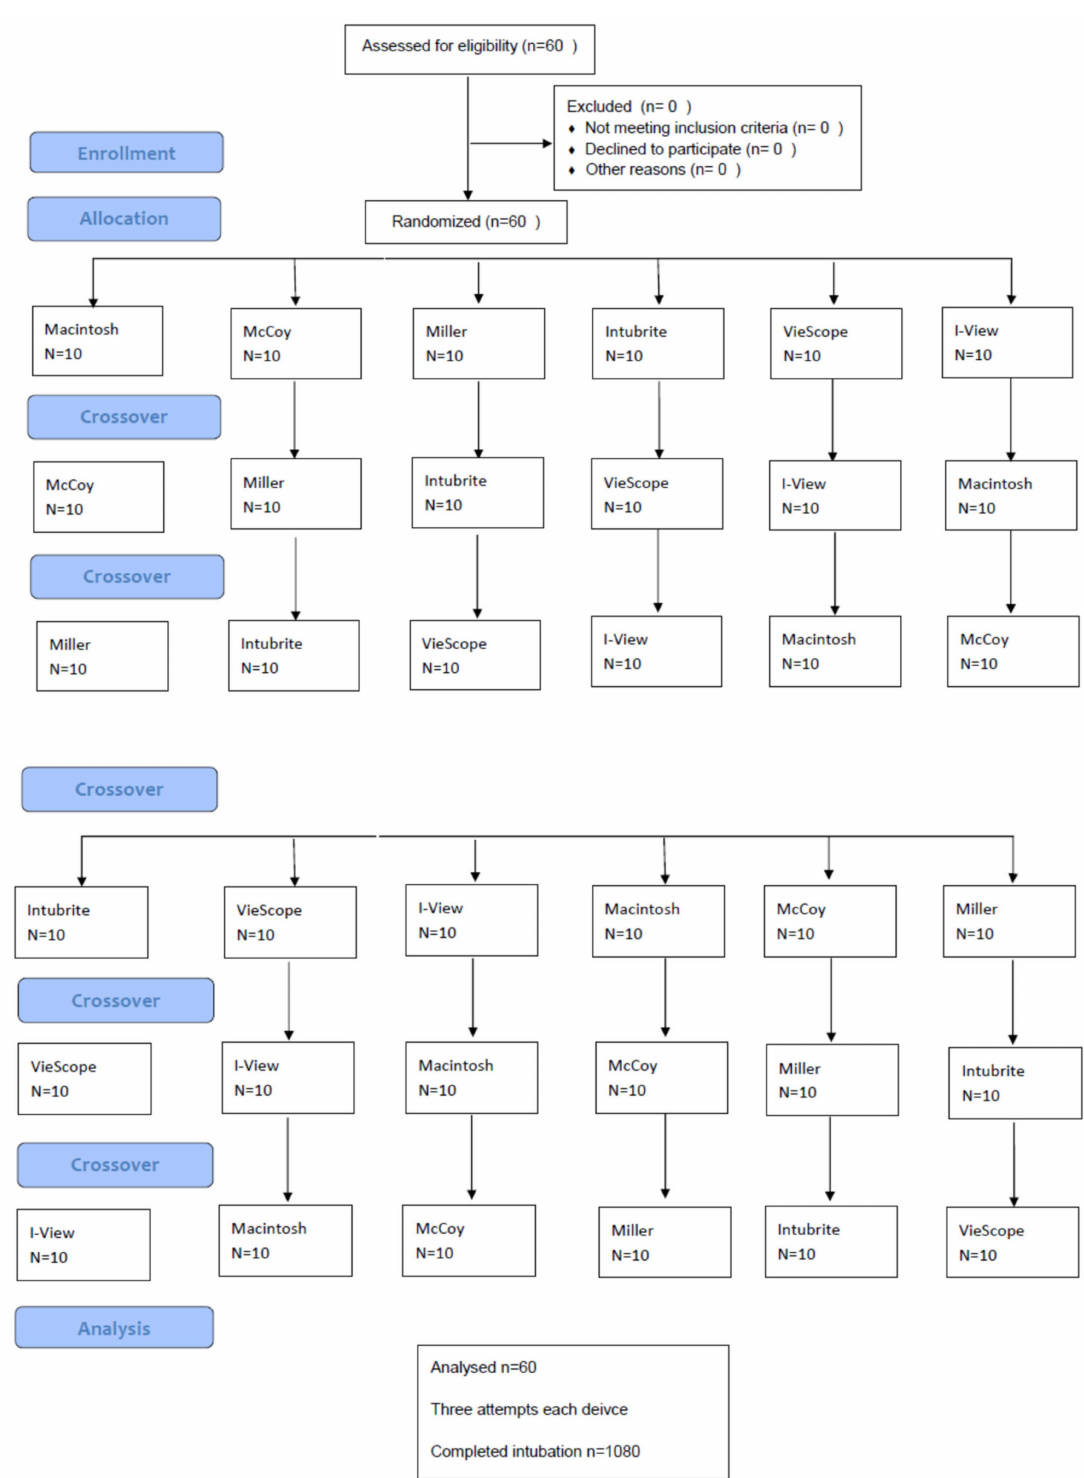
Figure 1. Flow chart. Each participant performed intubation in all settings in a randomized controlled order. There were no